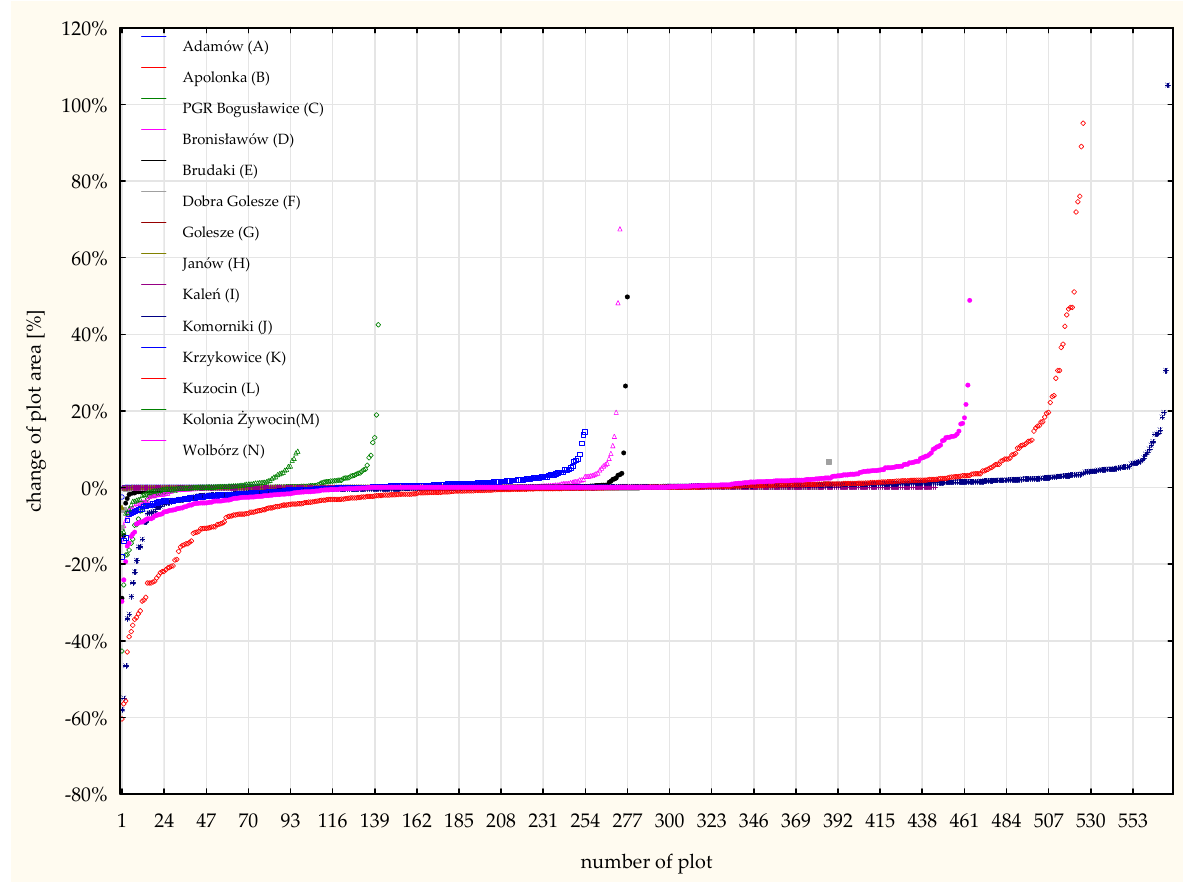
Figure 4. Distribution of plot area changes resulting from the cadastral data modernisation in the area under analysis. Source: own study.